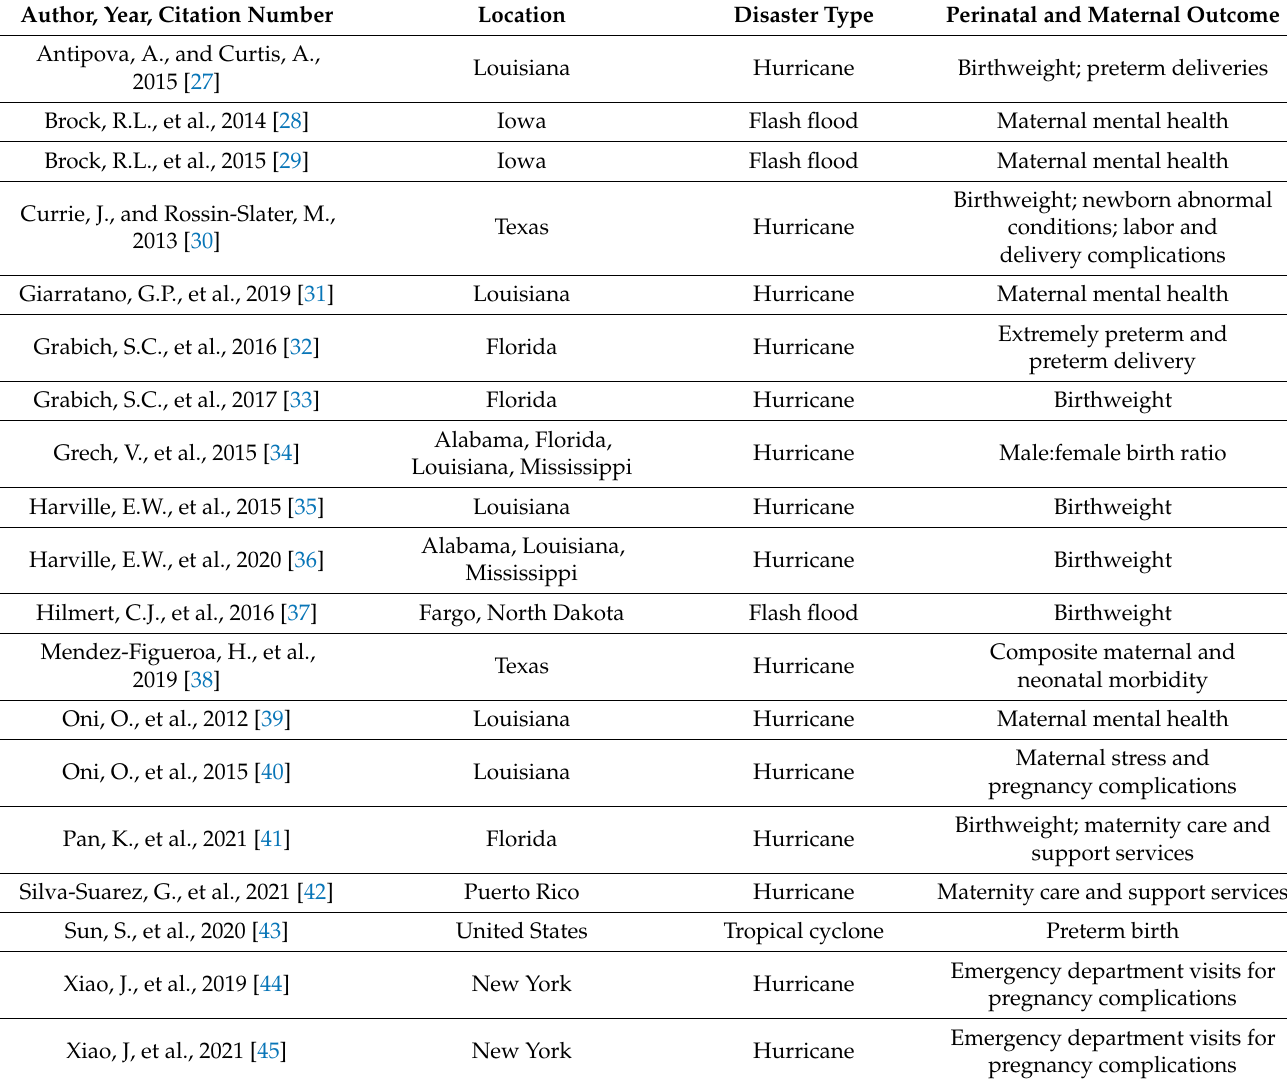
Table 4. Natural Disaster Exposure Studies ( n =